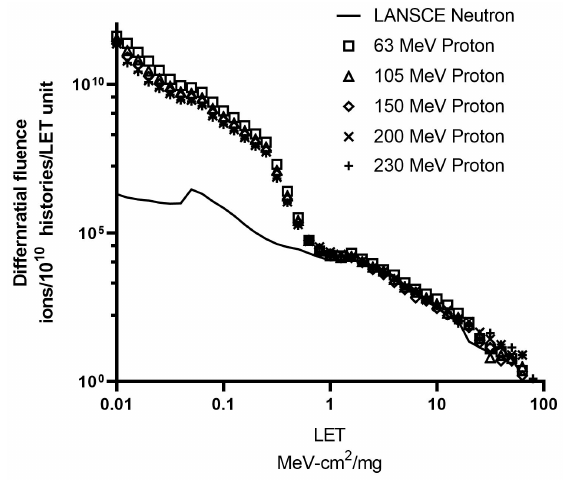
Figure 3. Linear energy transfer (LET) spectra in a structure without silicon-germanium (SiGe) irradiated by 63, 105, 150, 200, and 230 MeV proton and LANSCE neutron.